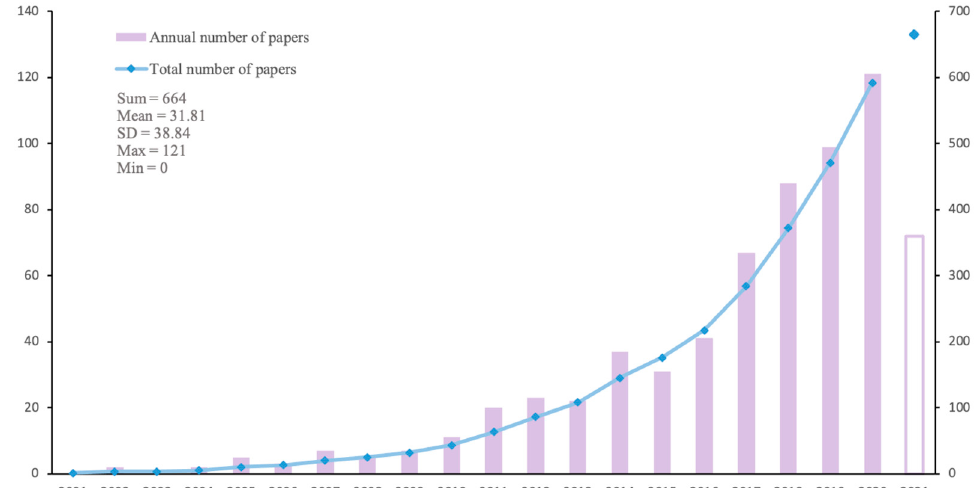
Figure 4. Trends in domestic research and publication. Table 2. Top 10 Chinese journals